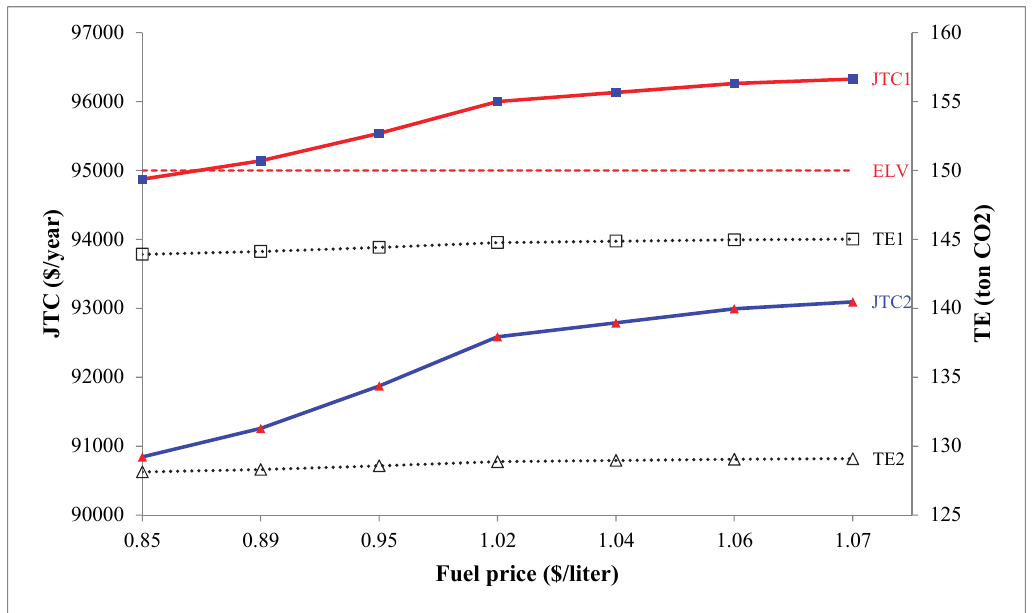
Fig. 11. Effect of changing in fuel price on total cost and emission